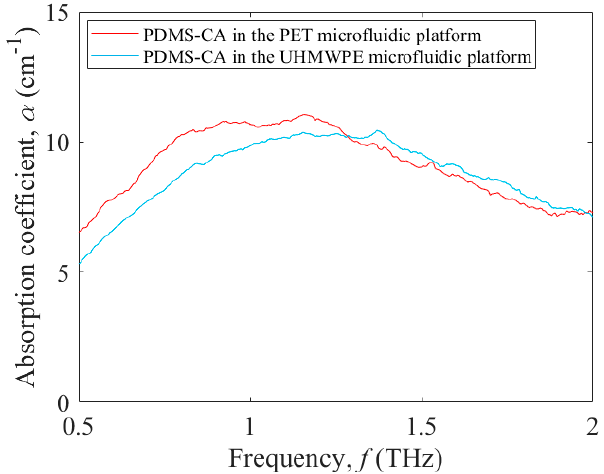
Figure 4. Terahertz absorption coefficient, α , versus frequency, f , from 0.5 to 2.0 THz for PDMS-CA as the test fluid in PET (red curve) and UHMWPE (blue curve) microfluidic platforms.